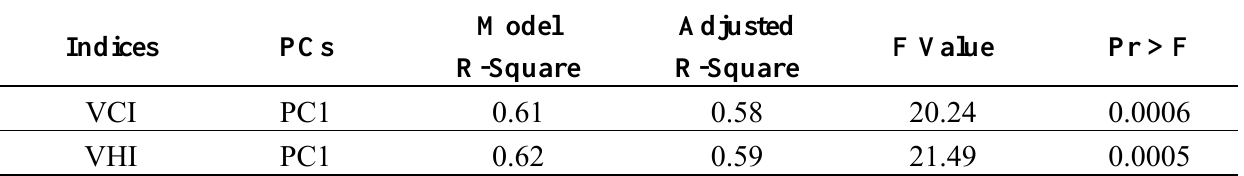
Table 1 . Summary of stepwise selection of VCI and VHI principal components for regression on aus rice